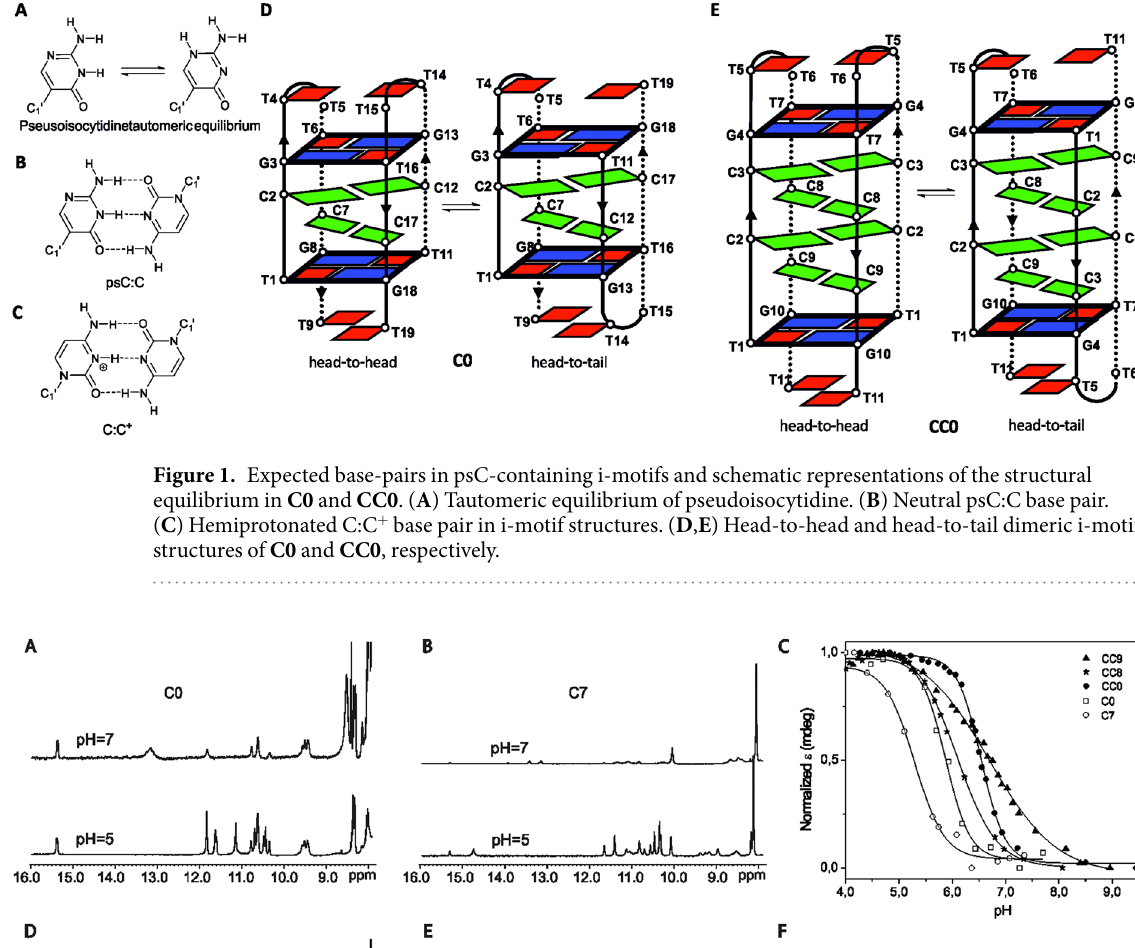
2 Scientific RepoRts | 7: 2772 | DOI:10.1038/s41598-017-02723-y